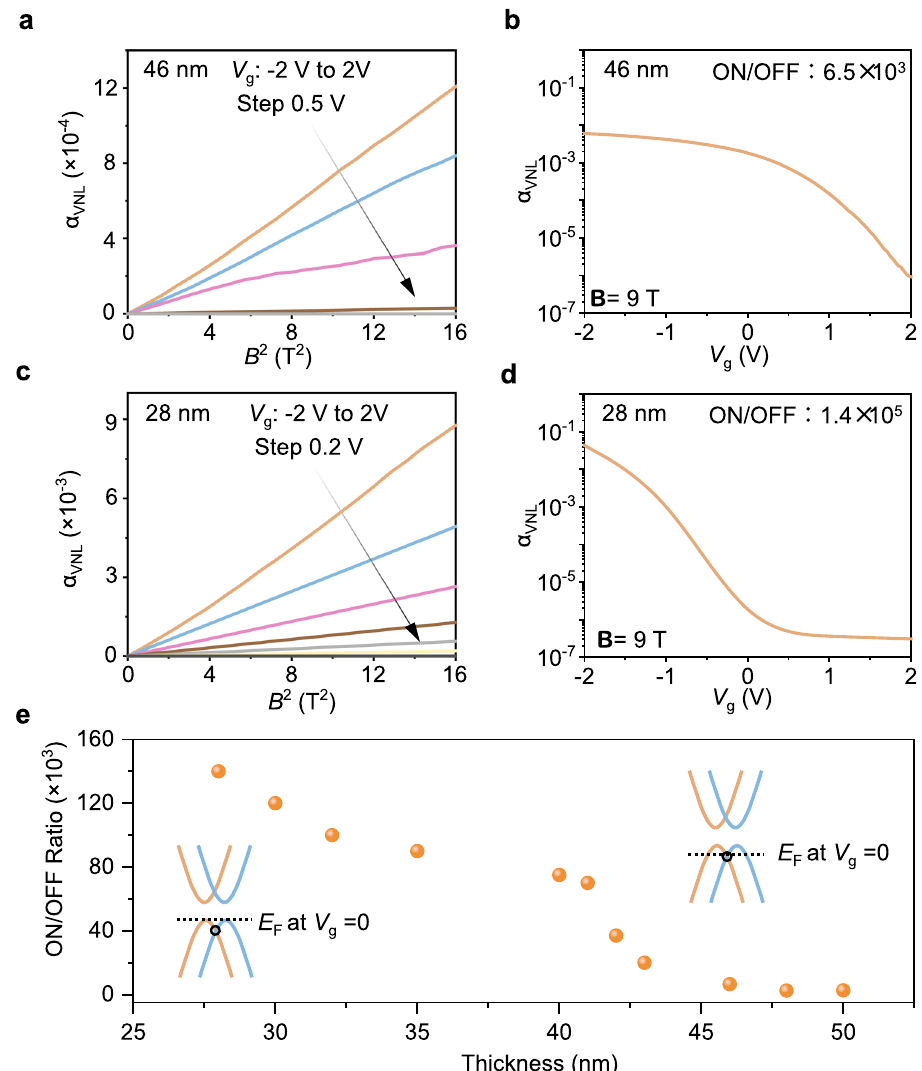
Fig. 3 | Volatilevalleytransistors atroom temperature under B//E. a Output and b transfer curvesfor the 46nm thick Te. α VNL isa dimensionless coef fi cient, which is de fi ned as | R VNL /R L |. c Output and d transfer curves for the 28nm thick Te. e ON/OFF ratio of valley FETs as a function of the sample thickness under B